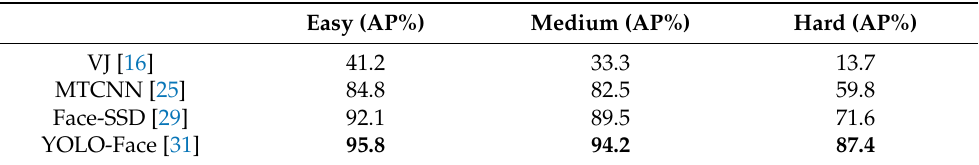
Table 3. Detection results on the WIDER FACE validation subset, evaluated with AP (%) on the validation